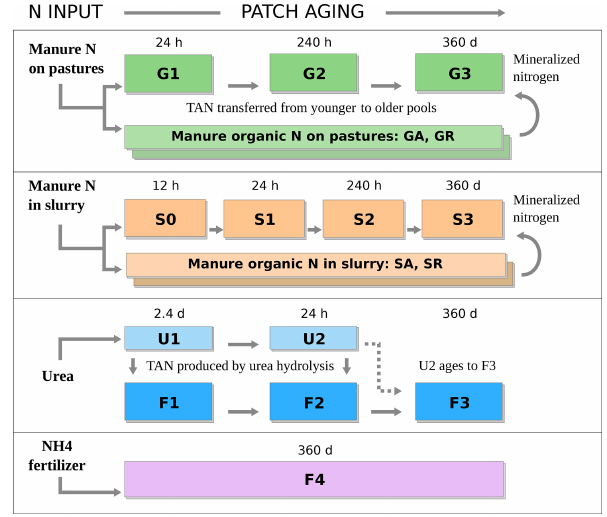
Figure 3. Age-segregated nitrogen pools in FANv2 for manure TAN on pastures (G1–G3), manure TAN in slurry (S0–S3), urea N (U1– U2), TAN produced by urea hydrolysis (F1–F3), and from other fer- tilizers (F4). GA and GR as well as SA and SR represent available and resistant organic N on pastures and in slurry. The age extent (cid:49)a in days or hours is indicated for each age